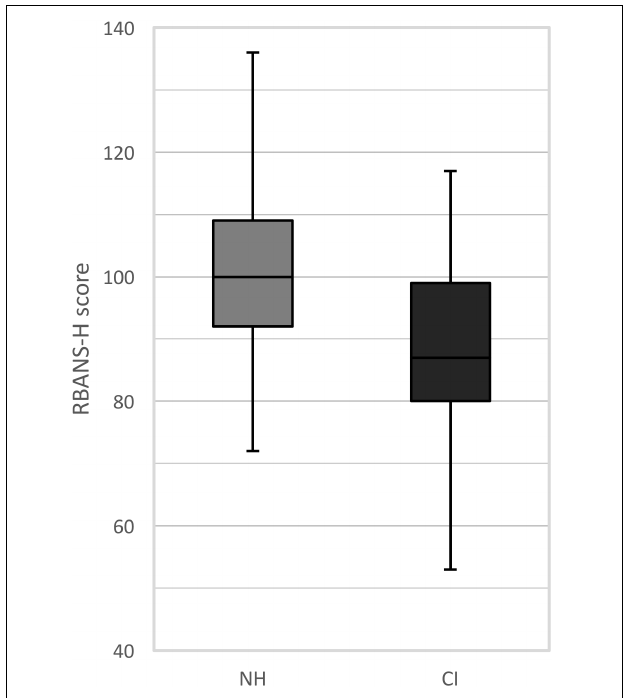
FIGURE 1 | Boxplots of the RBANS-H scores for the NH group (normal-hearing, gray boxplots) and the CI group (cochlear implant, black boxplots). The boxplots represent the minimum, 1 st quartile, median, 3 rd quartile and maximum of the RBANS-H total score.